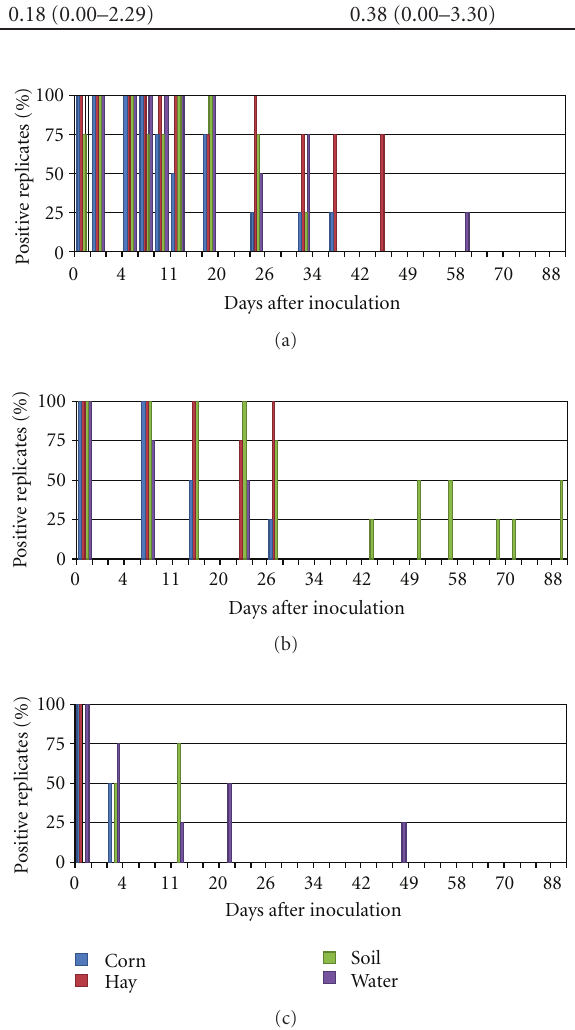
Figure 5: The percent ( n = 4 of each substrate) of M. bovis positive replicates of corn, hay, soil, and water at each sampling point in Fall/Winter (a), Winter/Spring (b), and Spring/Summer (c).